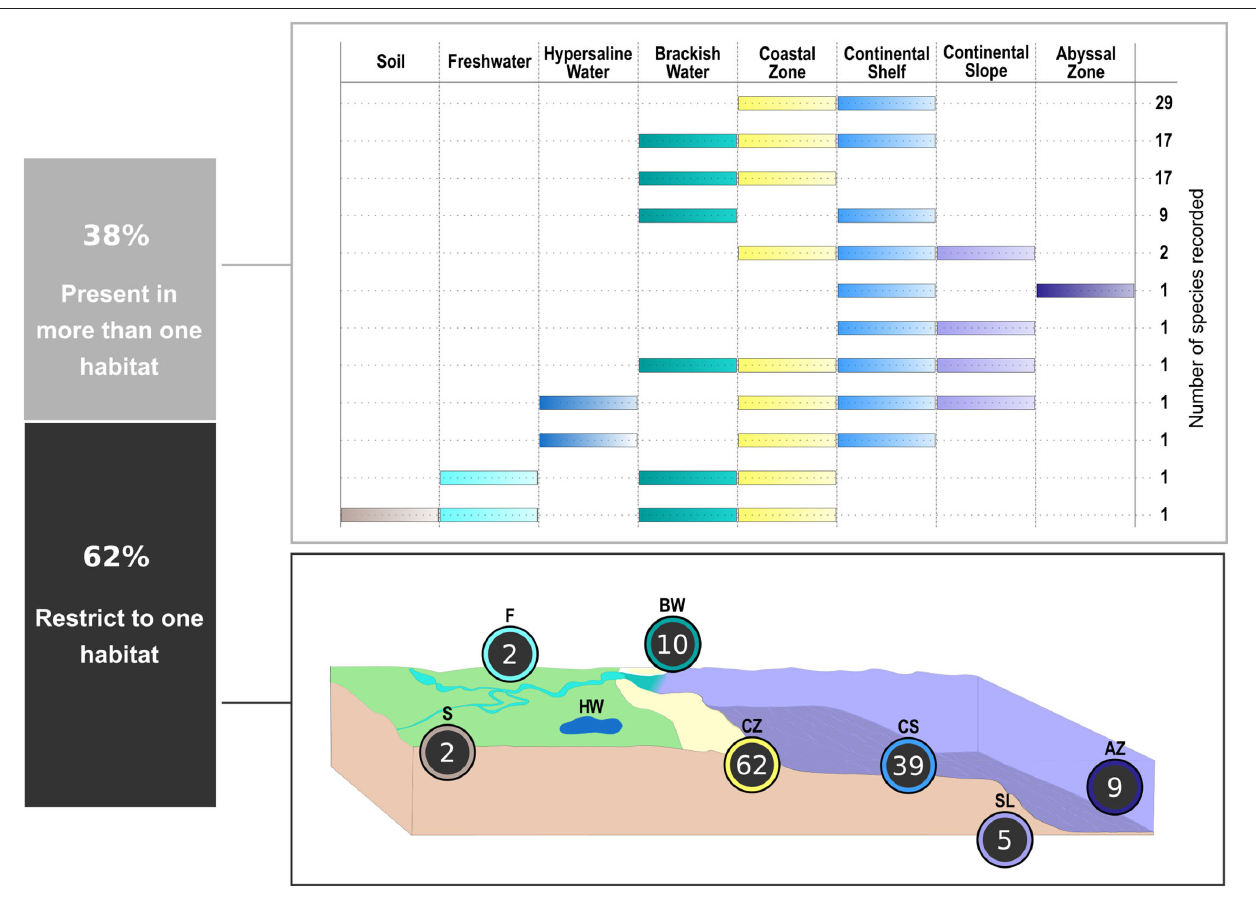
FIGURE 5 | Habitat distribution of the Cyatholaimidae species. The panel above shows the number of species occurring in more than one habitat. Below are the numbers of species exclusive of each habitat. S, Soil; F, Freshwater; HW, Hypersaline Water; BW, Brackish Water; CZ, Coastal Zone; CS, Continental Shelf; SL, Continental Slope; AZ, Abyssal